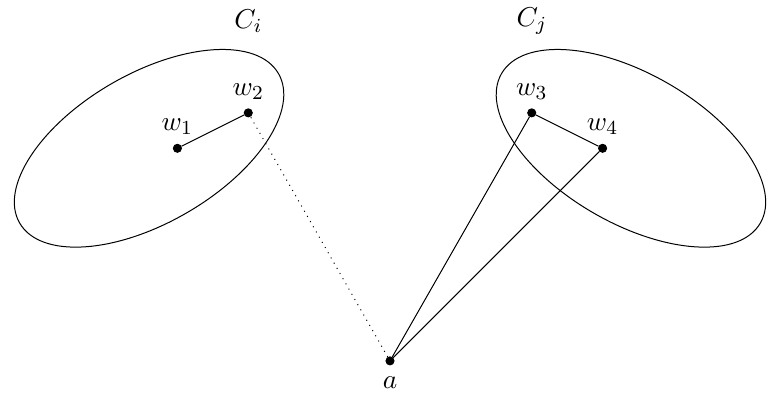
# – w · w a · aw , w w · 4 3 3 2 1 2 . j # – a · av · v v and jump from 1 2 2 1